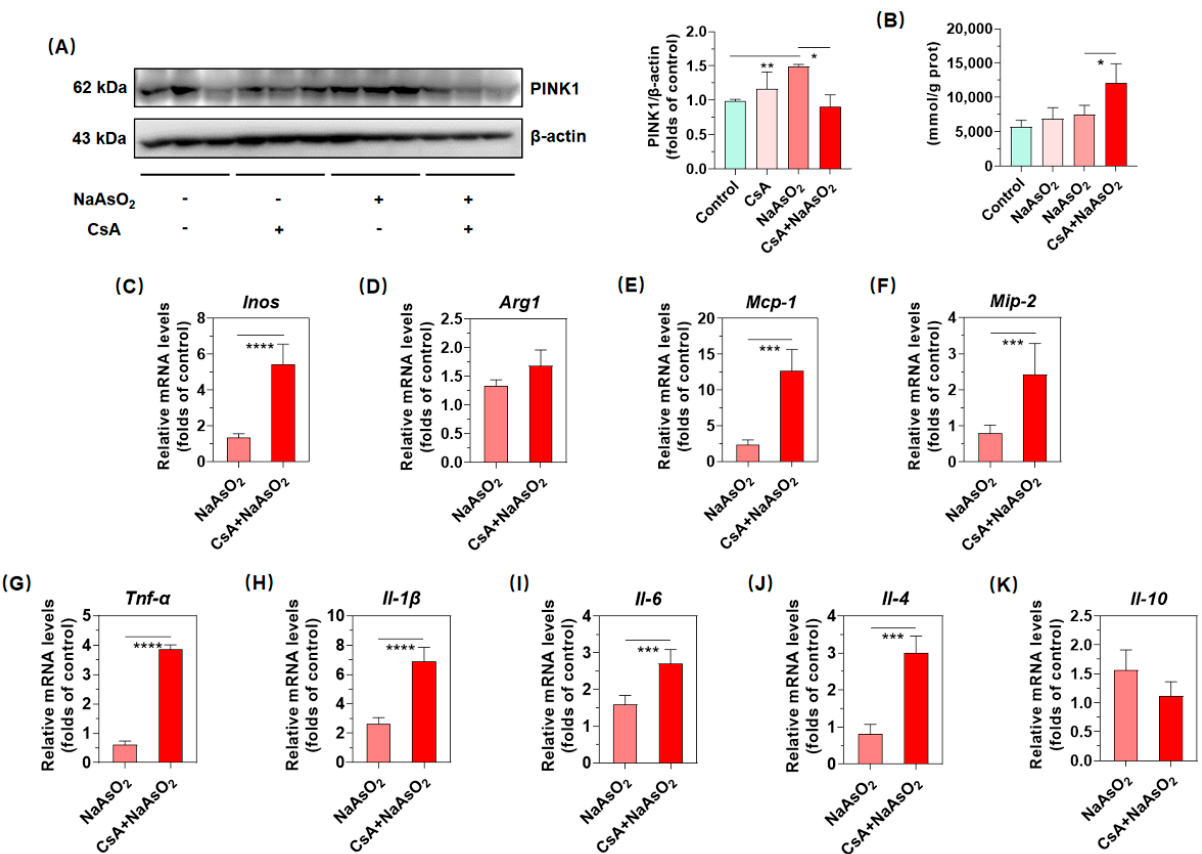
Figure 5. Compromised PINK1/Parkin-mediated mitophagy strengthened arsenic-induced gene expression of inflammatory cytokines in liver. ( A ) hepatic expression of protein PINK1 were deter- mined by Western blotting, of which protein densities are shown ( B ), ( C – K ) gene expression of Inos , Arg1 , Mcp-1 , Mip-2 , Tnf- α , Il-1 β , Il-6, Il-4 and Il-10 were determined by real-time qPCR, of which relative mRNA levels normalized to Gapdh in the livers of arsenic-exposed mice after pretreatment with 10 mg/kg CsA for 2 h are shown. Data are presented as mean ± SD ( n = 6). * denotes p < 0.05 compared with the NaAsO 2 group. ** denotes p < 0.01 compared with the control group. *** denoted p < 0.001 compared with the NaAsO 2 group. **** denotes p < 0.001 compared with the NaAsO 2 group.